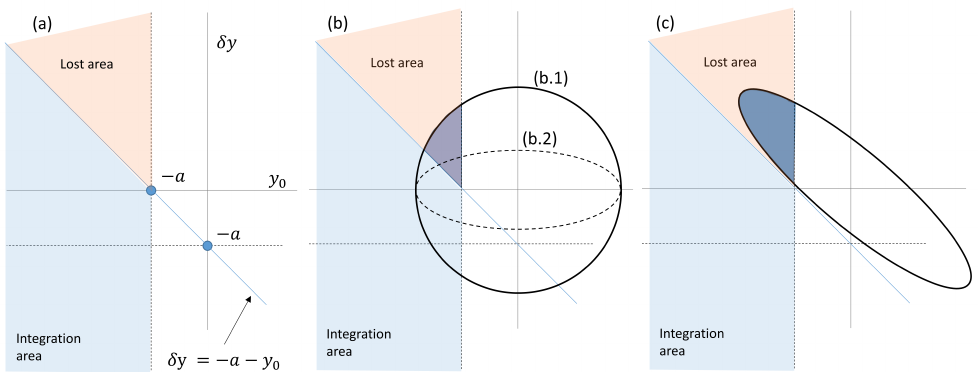
Figure 2. Geometric interpretation of the condition for the detection of incompliance events ( y < − a ). ( a ) Detection region D TP and lost area in the coordinate space spanned by the true wind speed changes (horizontal axis) and the forecast error (vertical axis). ( b ) Non-correlated joint probability distributions. (b.1) Similar variability of changes and forecast errors. (b.2) Forecasts errors about half the size of the variations. ( c ) Negatively correlated forecast errors and wind speed